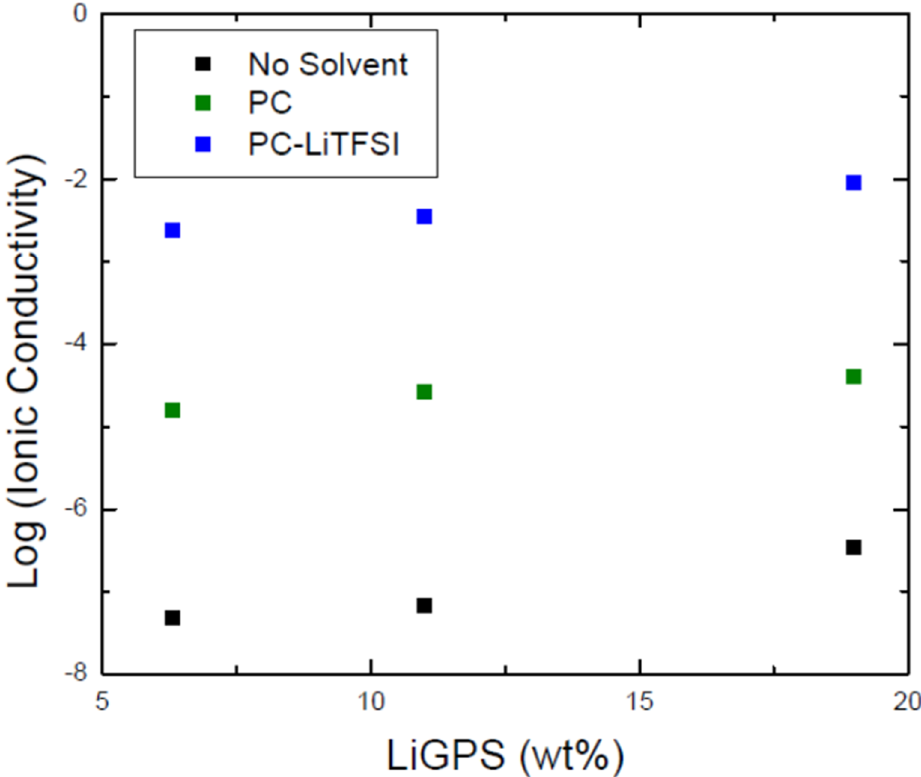
Figure 8. Ambient temperature ionic conductivity of polymer electrolytes comprised of DGEPEG, PEGBA and LiGPS with various solvent mixtures as a function of LiGPS weight percent. Made from data presented in Journal of Polymer Science Part A-1: Polymer Chemistry, 2010.